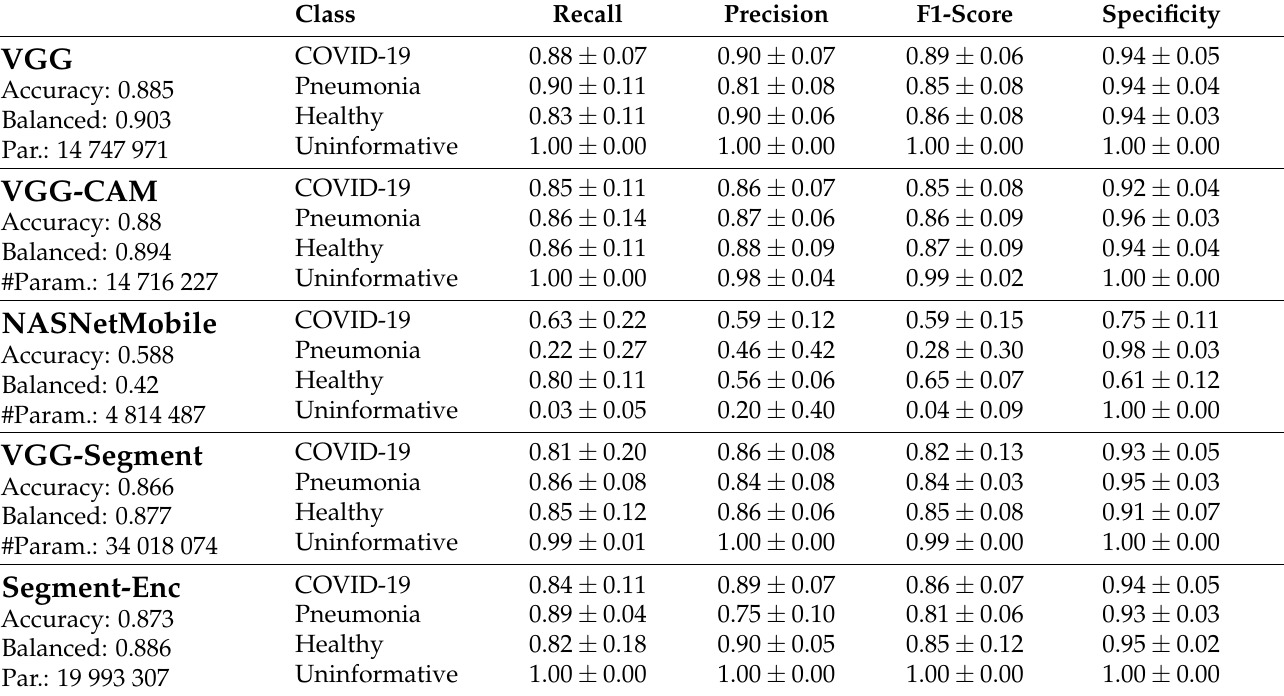
Table A2. Performance comparison including accuracy on the uninformative data. “Balanced” abbreviates balanced accuracy and Par. the number of parameters. The raw results are listed, including the uninformative class. Clearly, this fourth class is very distinctive and is learnt successfully, with almost all scores above 0.89. Class Recall Precision F1-Score